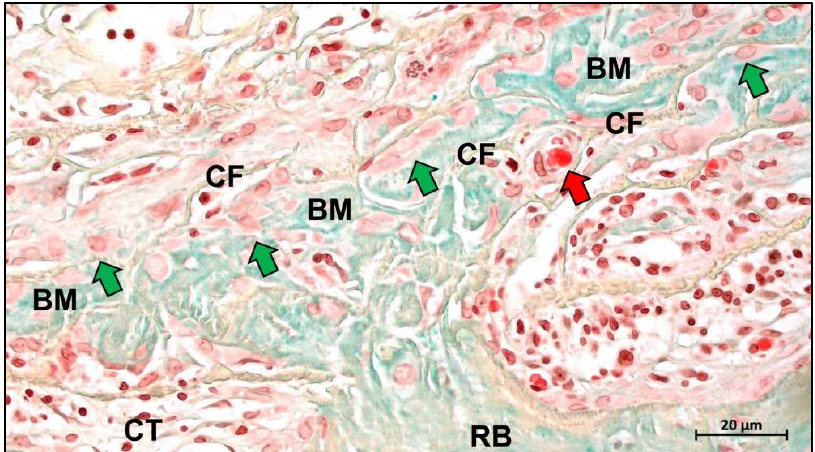
Figure 8. Representative histological image showing the bone ingrowth into a pericardium-based collagen membrane at 2 weeks post implantationem. BM = newly formed bone matrix within the membrane, green arrows = osteoblasts, red arrow = blood vessel, CF = collagen fibers of the mem- brane, RB = residual bone, CT = connective tissue (Movat Pentachrome staining, 400 × magnification, scalebar = 20 µ